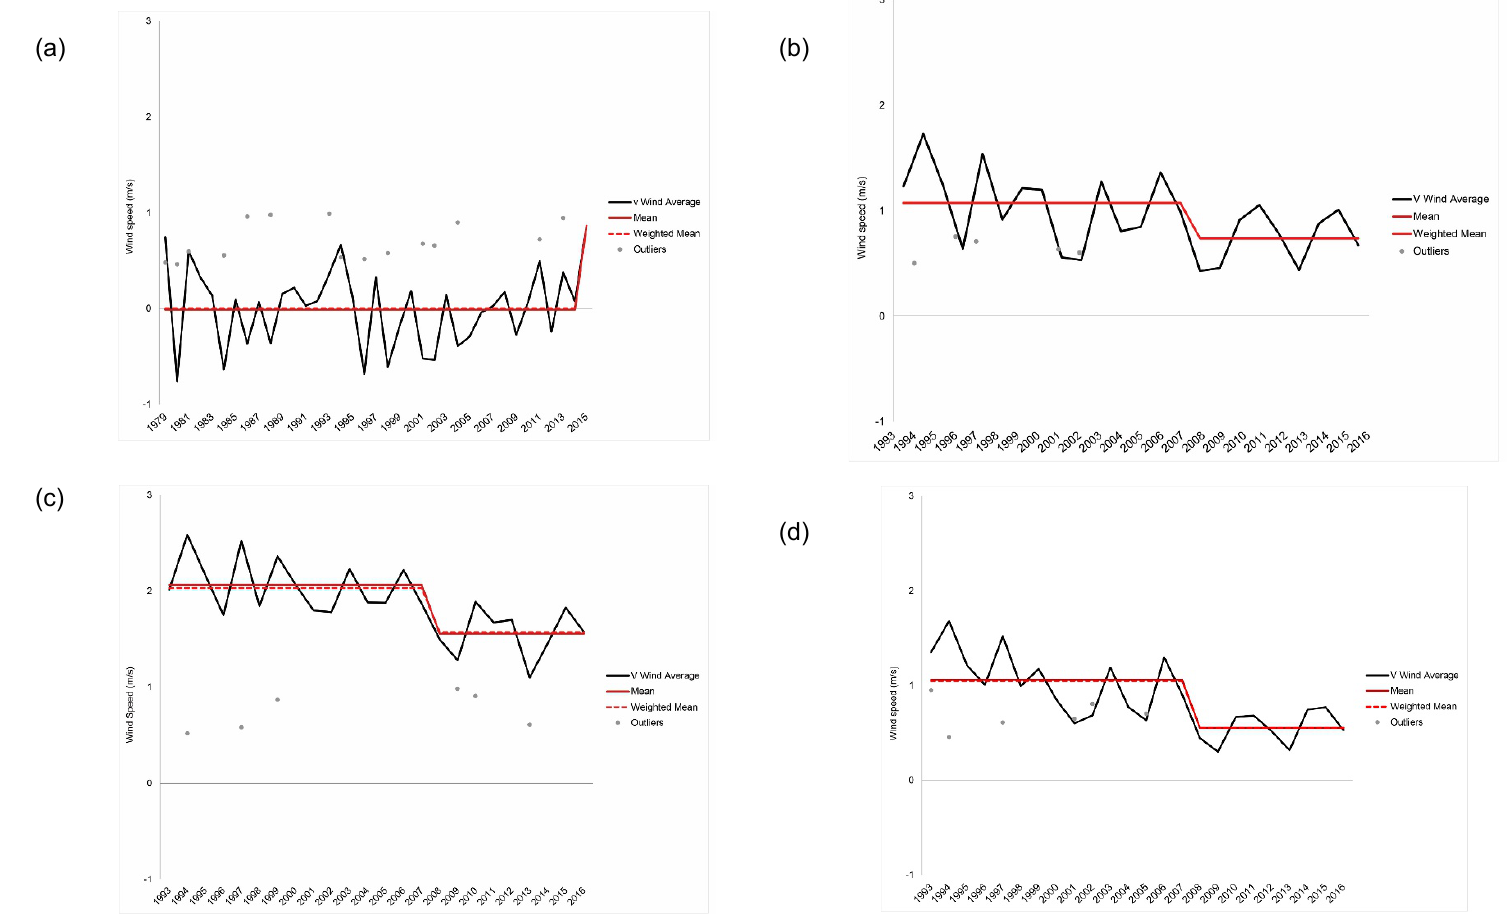
F igure A5.4: Autumn mean values for V component of wind speed for (a) NCEP-DOE, (b) scatterometer aggregate, (c) Witsand and (d) Mossel